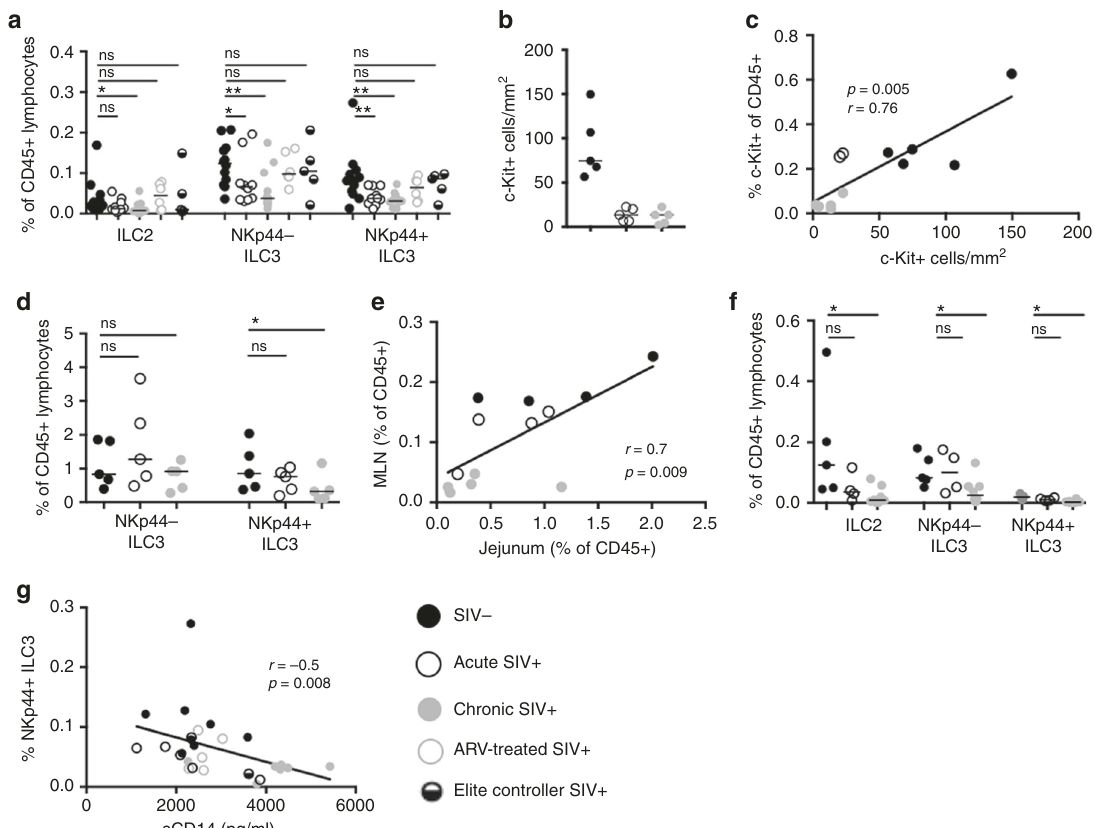
Fig. 2 Local and systemic depletion of ILCs in untreated SIV infection. a Frequencies of MLN ILCs in healthy uninfected RMs ( N = 10), untreated acute and chronic SIV-infected RMs ( N = 10) ( N = 11), chronic SIV + RMs receiving ART ( N = 6), and SIV-infected ECs ( N = 4). Determined as a proportion of viable CD45 + hematopoietic cells. b Summary data of CD3-c-Kit + cell number per area of paracortical region in the MLN. c Relationship between c-Kit + LC3 proportions assessed by fl ow cytometry and c-Kit + ILC3 enumeration by microscopy. d Frequencies of ILC3s in jejunal cell suspensions. e Correlation of NKp44 + ILC3 frequencies in animals with matching MLN and jejunal samples at the time of necropsy. f Frequencies of ILCs in axillary lymph nodes. g Relationship between NKp44 + ILC3 frequencies in the MLN and sCD14 in plasma. Statistical signi fi cance was calculated using the Mann – Whitney test. A Pearson's correlation was calculated for panels c , e , and g . ns = P > 0.05, * = P ≤ 0.05, ** = P ≤ 0.01, *** = P ≤ 0.001, and **** = P ≤